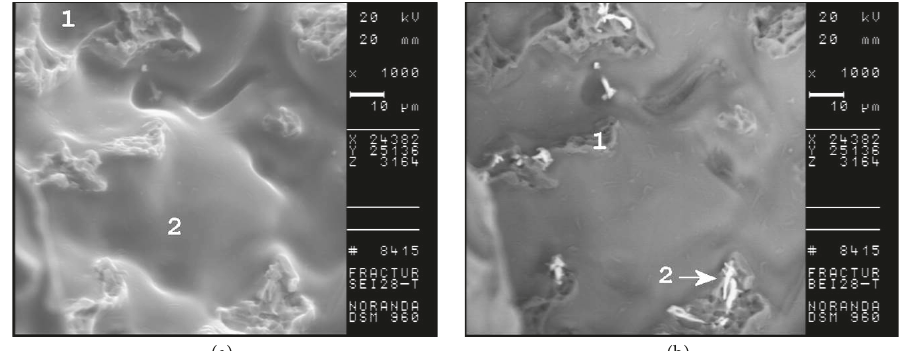
Figure 8: (a) Secondary electron image of the B alloy, 7% Al; (b) backscattered electron image of (a).